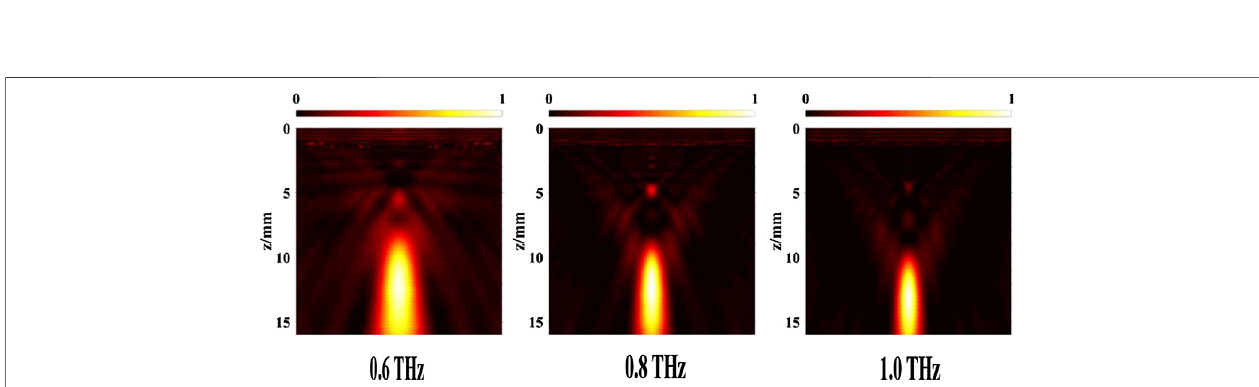
Frontiers in Physics |